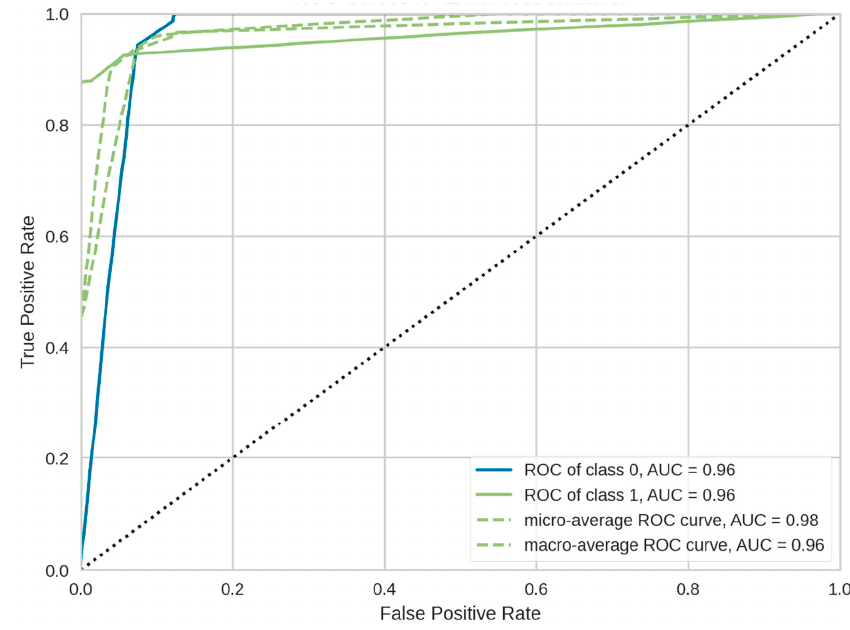
Figure 13. ROC curve of the feature-engineered–NGBoost classifier (proposed model).